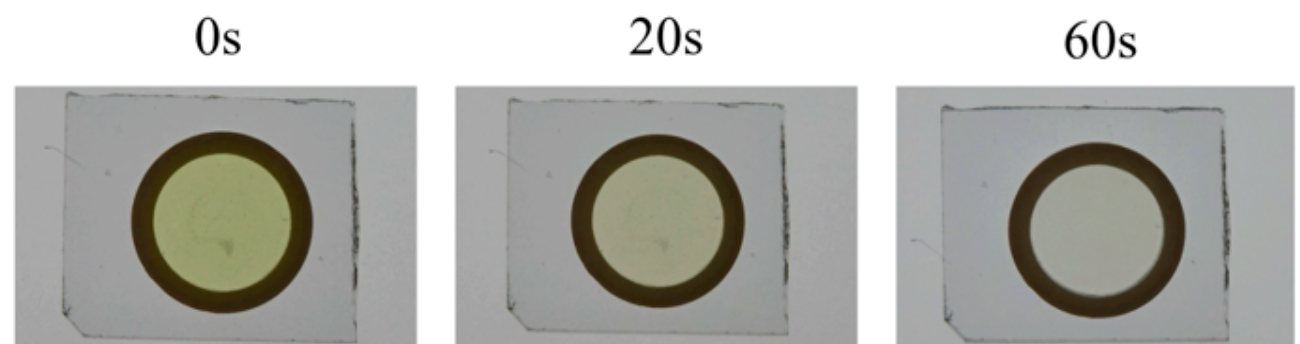
Figure 1. Gelatin methacryloyl–riboflavin (GelMA-RF) before and after photopolymerization. The three images show a 20% GelMA-RF hydrogel before and after photopolymerization under visible-wavelength (VW) light. Before photopolymeriza- tion, the GelMA–RF hydrogel was translucent and dark yellow. After 20 s of photopolymerization, the GelMA–RF hydrogel was translucent and pale yellow. After 60 s of photopolymerization, the GelMA–RF hydrogel was almost completely transparent. Furthermore, 10% and 15% ( w / v ) GelMA–RF gels were too weak to be handled for testing after 20 s and 60 s of photopolymerization (data not shown).